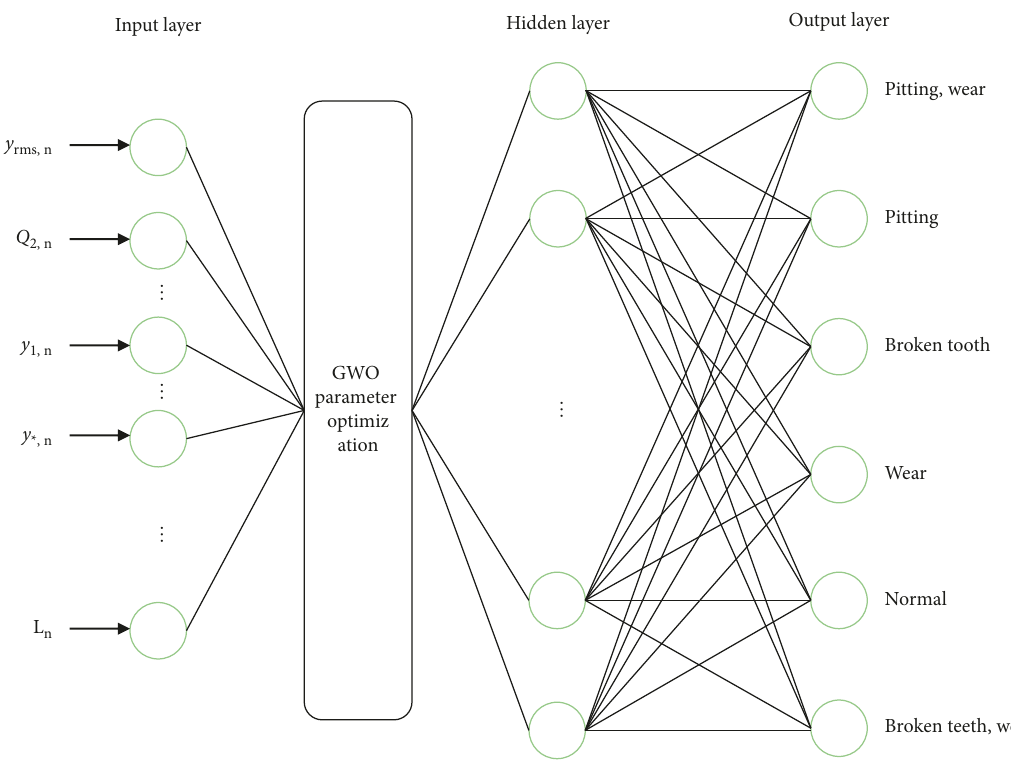
Figure 4: Fault diagnosis model of GMO-KELM based on SLFNs.